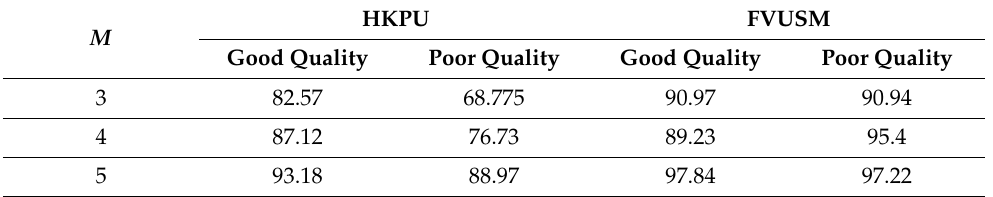
Table 8. Impact of Increasing Depth of the Network on the Recognition Performance of the FVR-Net. M